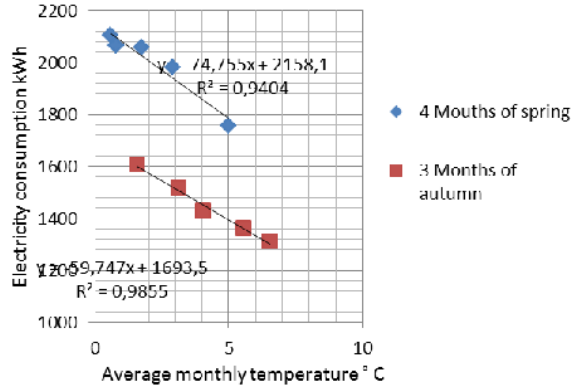
Fig.6. Dependence of consumption on temperature